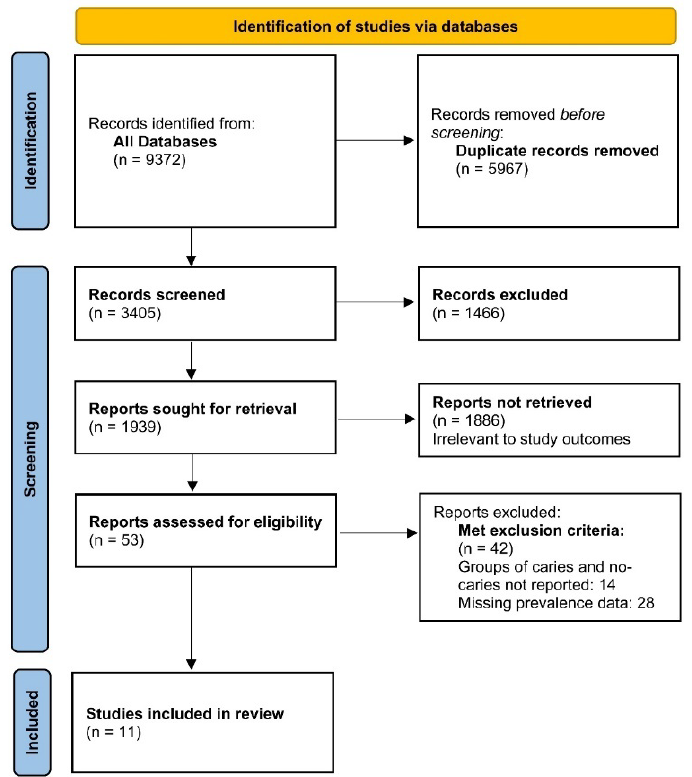
Figure 1. The PRISMA flow diagram.